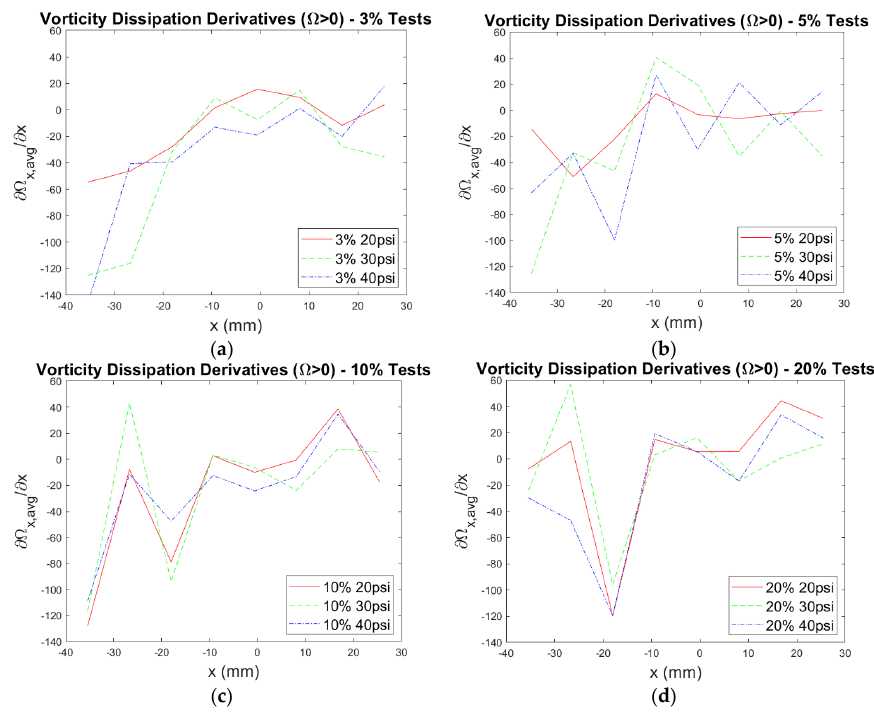
Figure 22. Vortex dissipation numerical x-derivative for ( a ) 3%, ( b ) 5%, ( c ) 10%, and ( d ) 20% freestream wind tunnel settings.